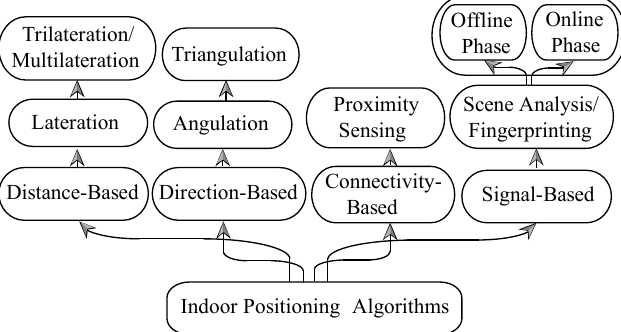
Figure 8. Description of the overall indoor positioning algorithms.